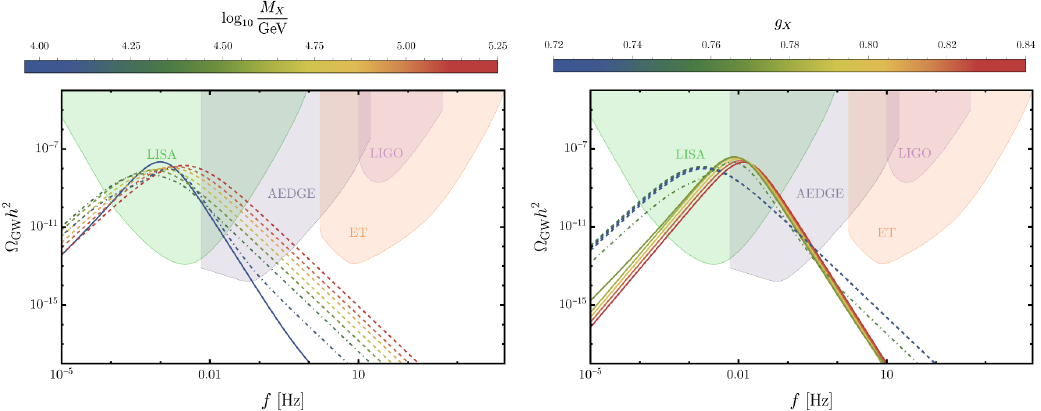
Figure 12 . Predictions for spectra of gravitational waves together with integrated sensitivity curves for LISA, AEDGE, ET and LIGO. Left: for a fixed value of g (color-coded). Right: for a fixed value of M